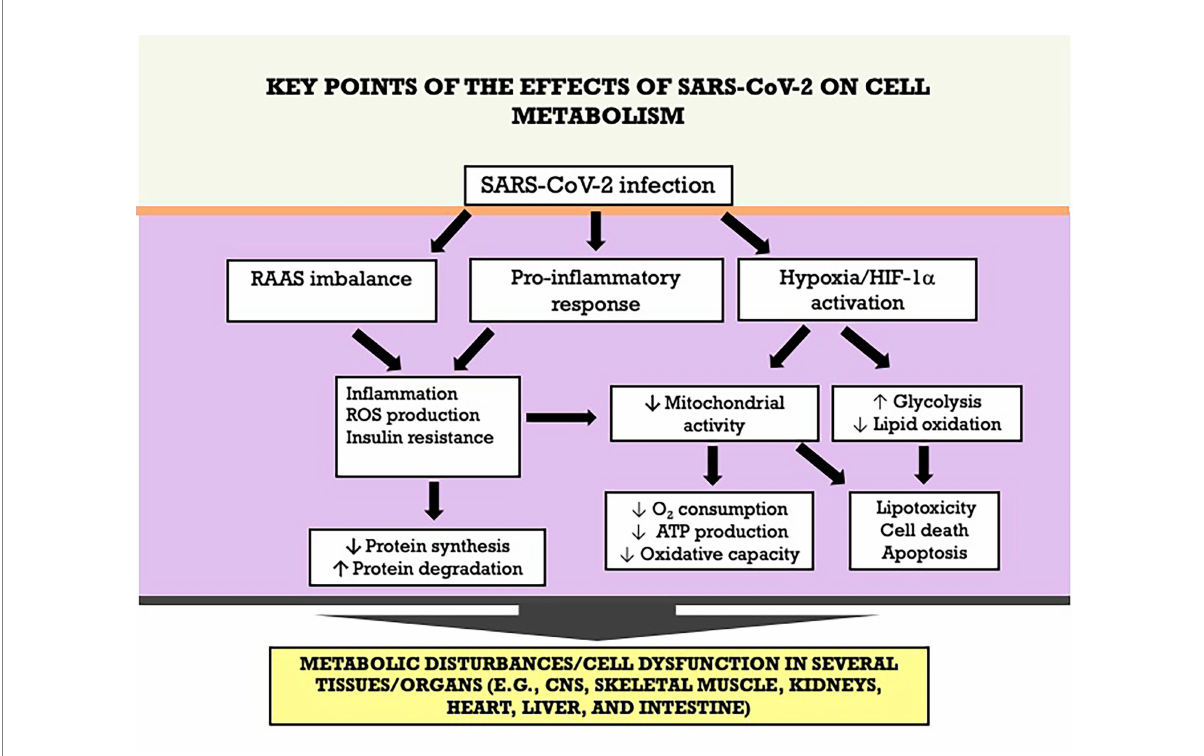
FIGURE 7 Key points of the effects of SARS-CoV-2 on cell metabolism an tissue/organ dysfunction. ATP adenosine triphosphate; HIF-1 α , hypoxia-inducible factor-1 alpha; RAAS, renin-angiotensin-aldosterone system; ROS, reactive oxygen species.